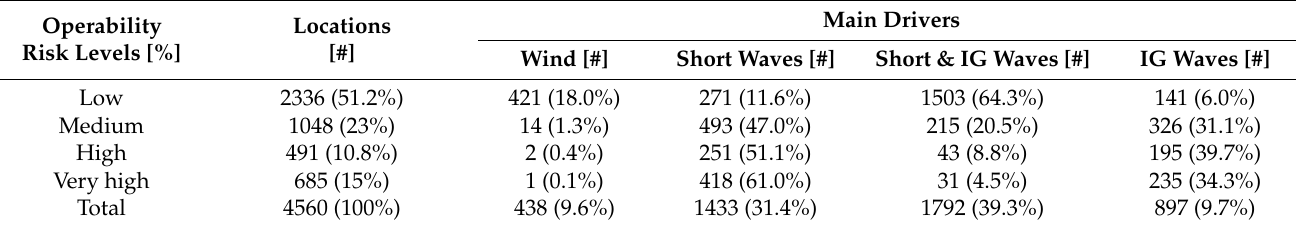
Table 4. Overview of the main operability-issues drivers for 4560 locations, differentiated into four operability risk indicator classes and categorized in operability risk level